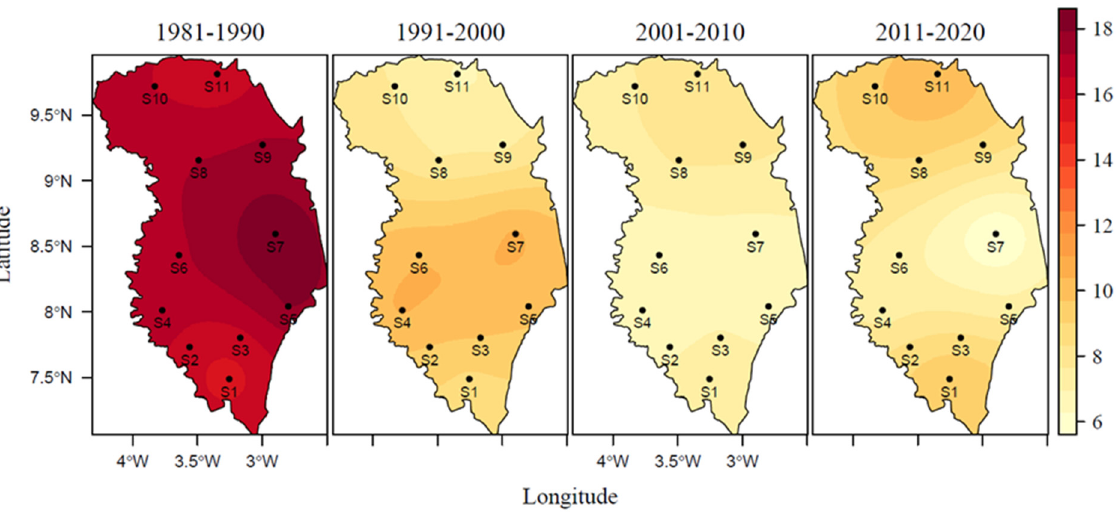
Figure 8. Spatial distribution of number of cool days (TX10p) (%) per decade in Zanzan region. Stations (S1 = Koun Fao, S2 = Kouassi-datékro, S3 = Tanda, S4 = Sandegué, S5 = Bondoukou, S6 = Nassian, S7 = Sapli, S8 = PN Comoé S1, S9 = Bouna, S10 = Téhini, S11 = Doropo).